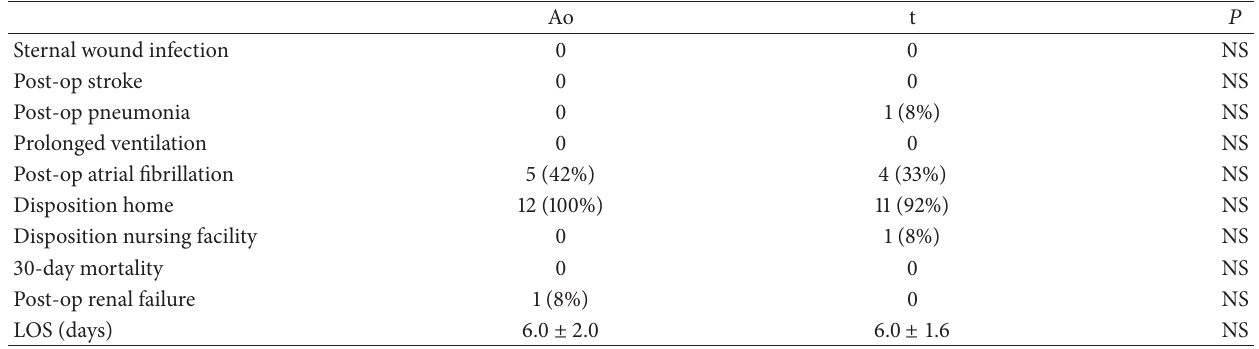
Table 5: Follow-up angiography. Ao t Time to catheterization (months) 12.5 ±